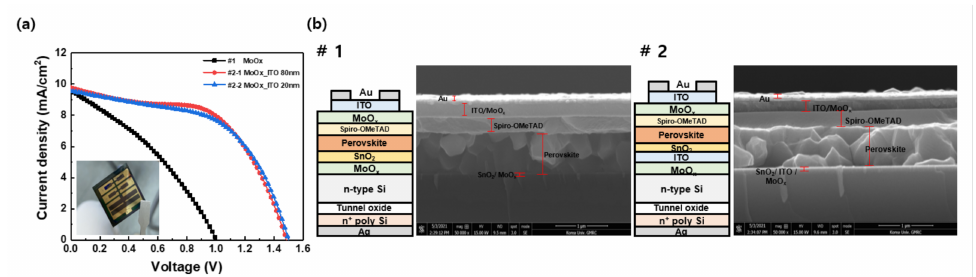
Figure 5. ( a ) J-V curves and ( b ) schematic of the structures of the monolithic perovskite-carrier selective contact silicon tandem solar